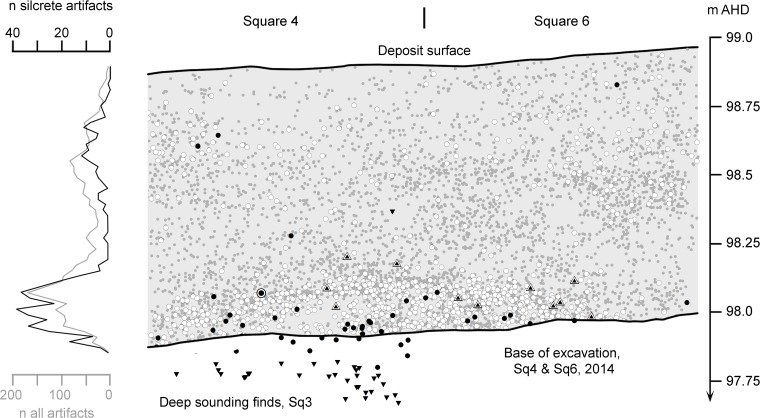
Distribution of artefacts in the Mertenhof sequence.Non-silcrete artefacts (filled grey circles) and silcrete artefacts (white circles) are shown from squares 4 and 6 only (see S2 Text for square locations). Unifacial points (nested triangles), backed artefacts (black circles), bifacial points and thinning flakes (inverted black triangles) are shown from all excavated squares, including the deep sounding square 3. The single nested circle represents a core with Nubian characteristics. Frequency histograms for all artefacts (grey line and scale) and silcrete artefacts (black line and scale) are generated using arbitrary 20 mm horizontal bins.